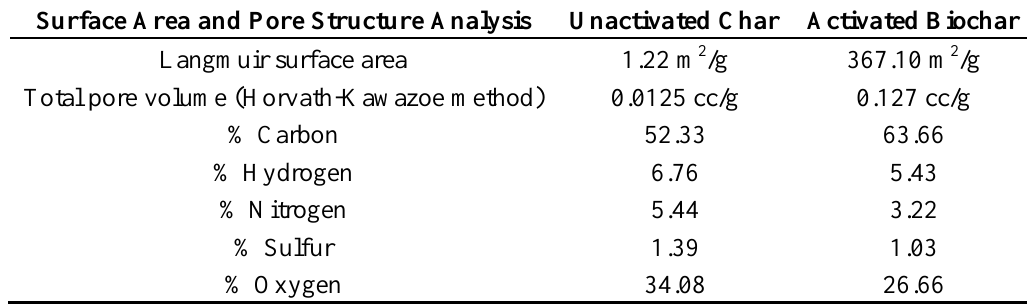
Table 2. Physicochemical characteristics of unactivated and activated